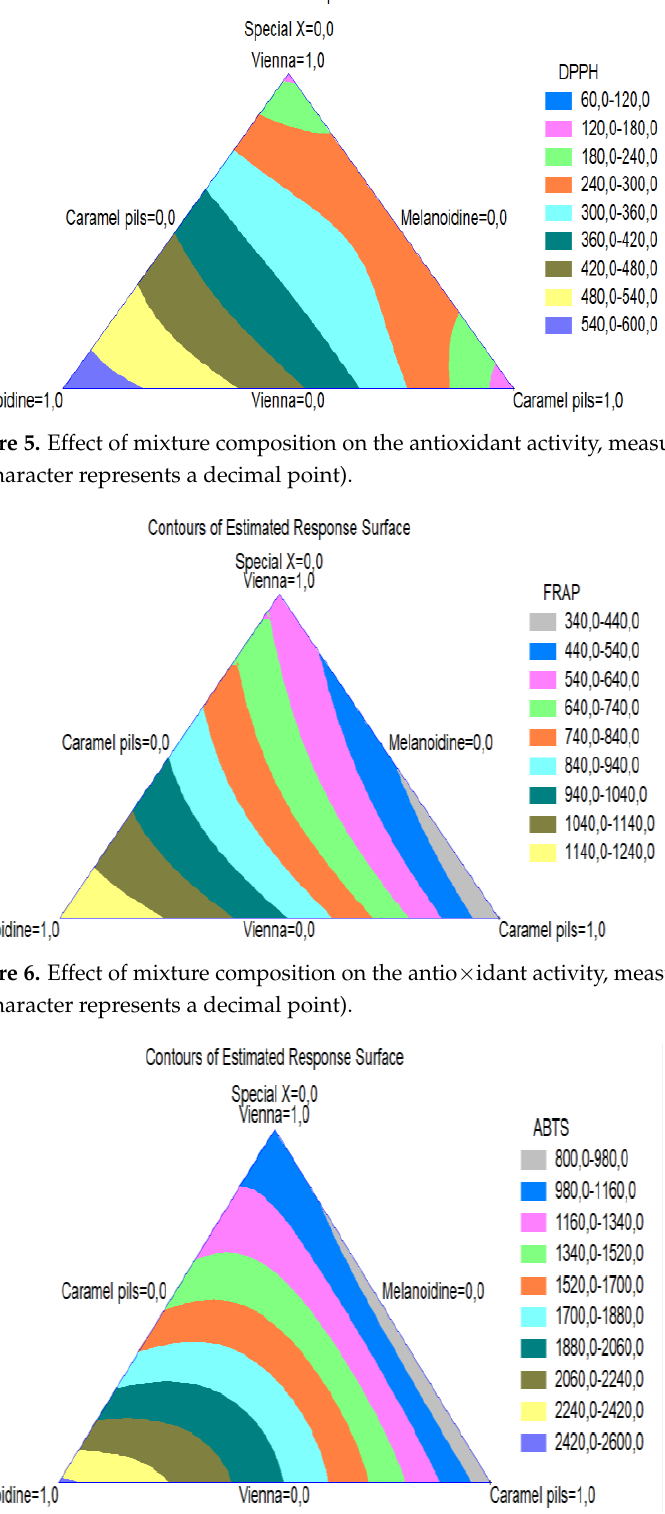
Figure 7. Effect of mixture composition on the antioxidant activity, measured by ABTS method. (the “ , ” character represents a decimal point).